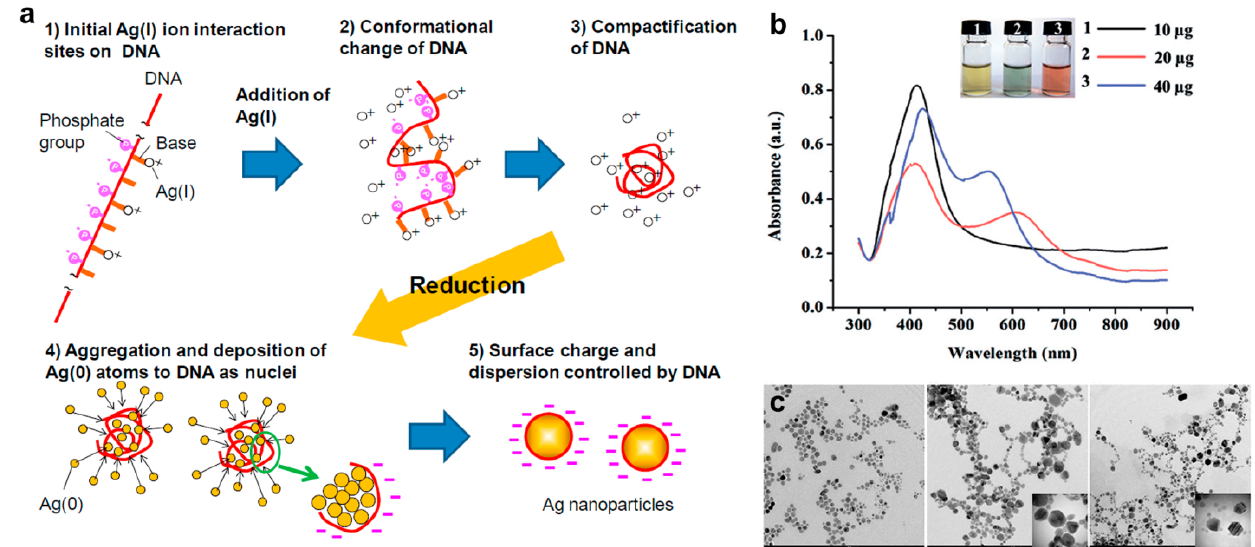
Figure 4. A schematic representation of DNA-promoted synthesis of AgNP ( a ). Reproduced with permission from [111] under the Creative Commons Attribution (CC BY) license (https://creativecommons.org/licenses/by/4.0/). Accessed on 25 November 2021. UV-Vis spectra of AgNP ( b ) and TEM images (scale bar is 50 nm) ( c ) of AgNP obtained under blue light and different DNA content (left–10 µg, middle–20 µg, right–40 µg). Reproduced with permission from [114]. Copyright 2018 Taylor & Francis.